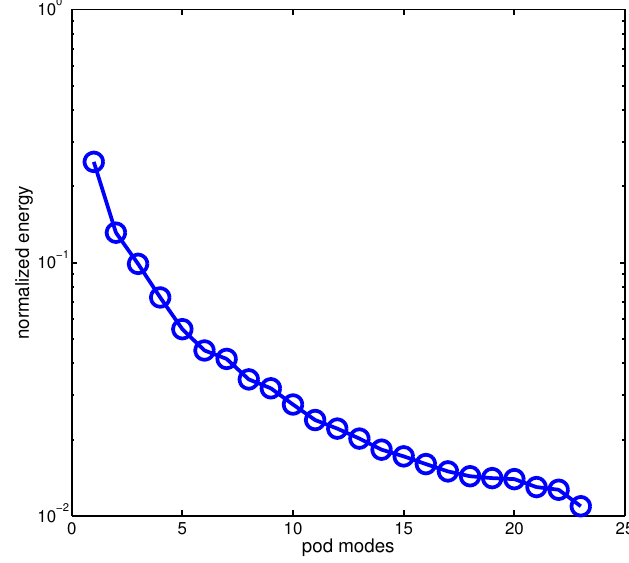
Figure 2. Normalized POD spectra of total